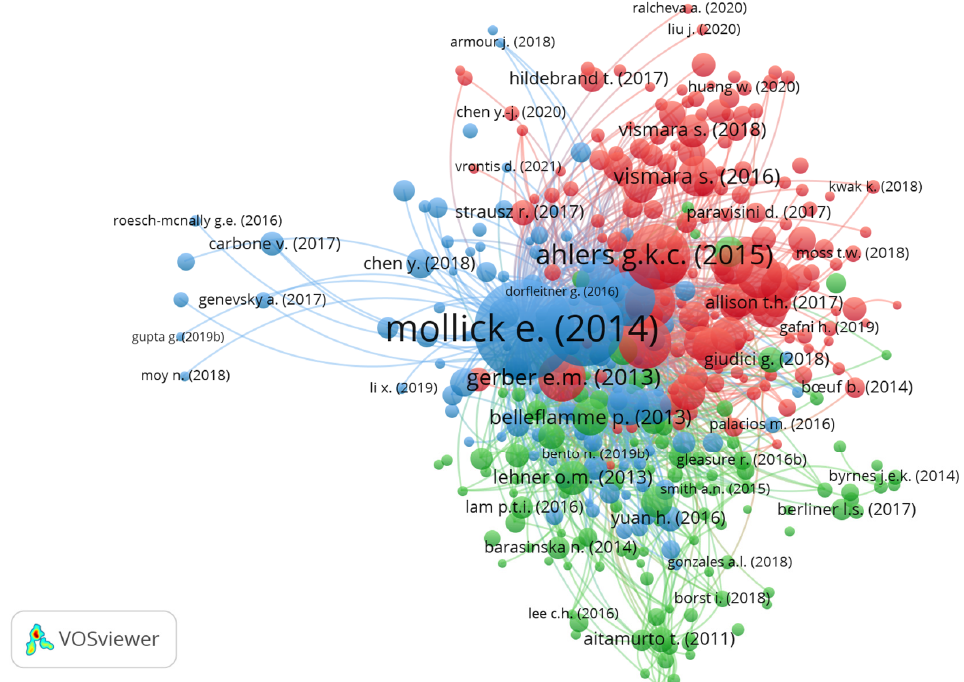
Figure 8. Citation analysis of